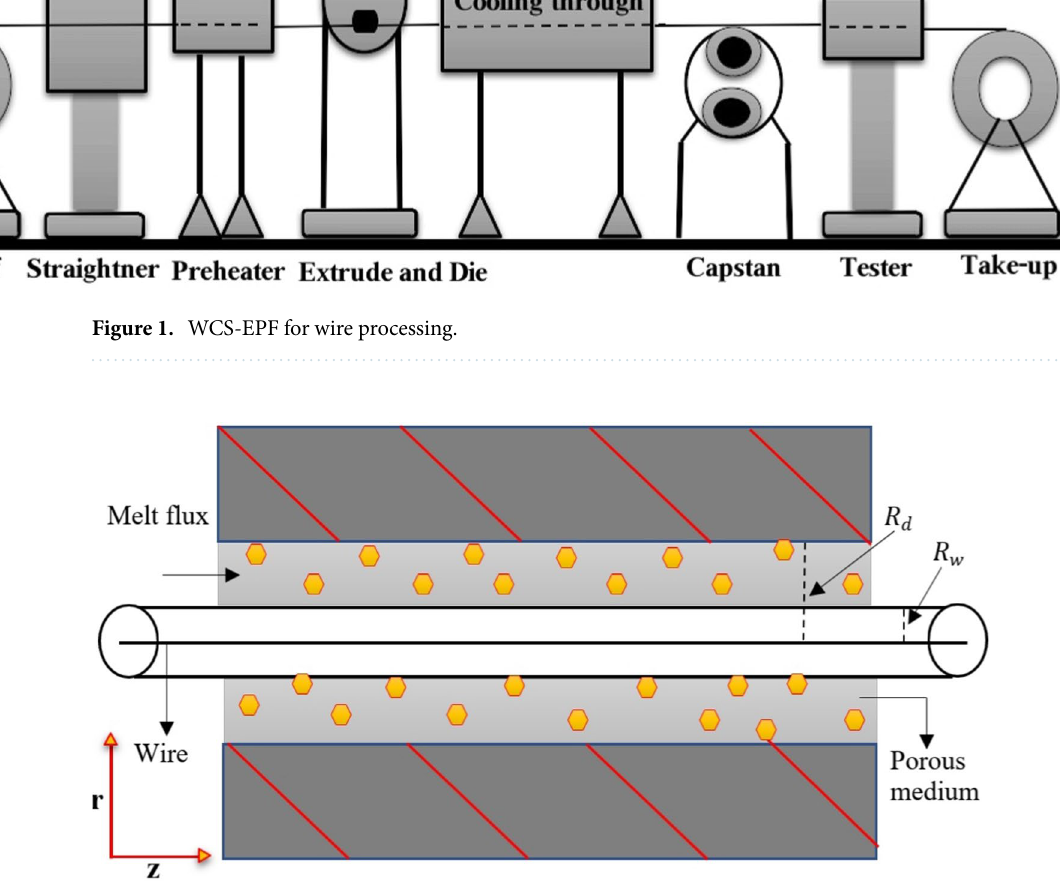
Figure 2. Graphical representation of fluid flow through a hydrodynamic pressure